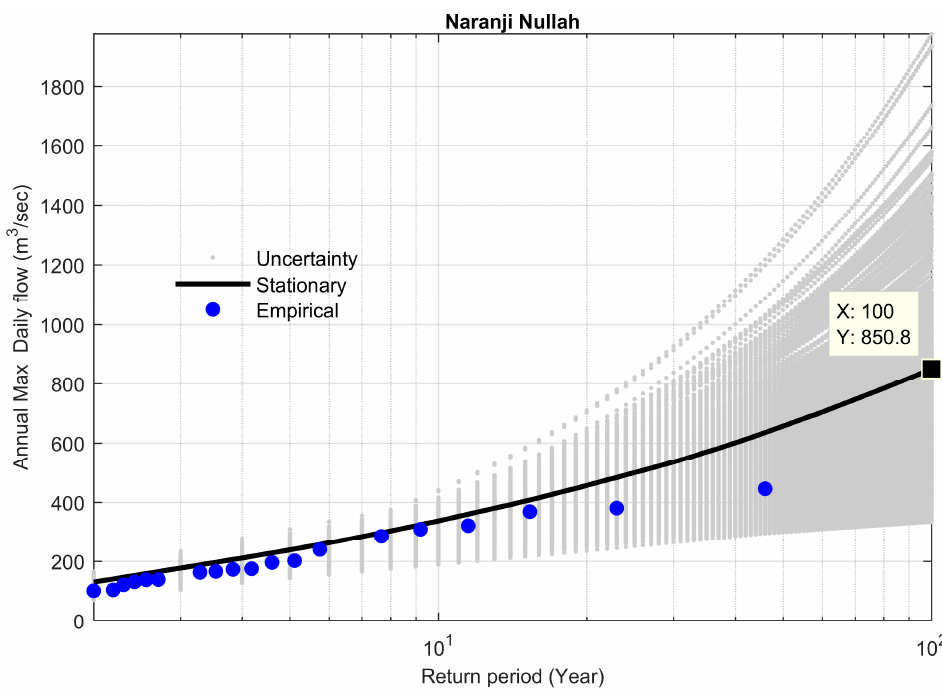
Figure 17. FFCs at site 16, along with stationary uncertainty bounds for the year 2009.